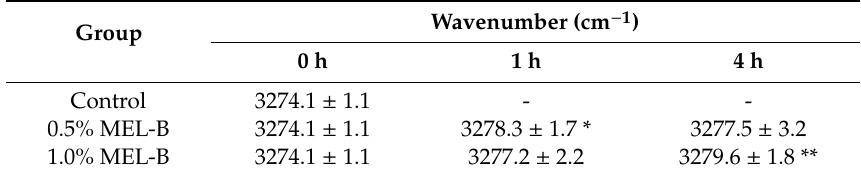
Table 2. OH stretching frequencies following the application of MEL-B liposomes containing calcein to hairless mouse stratum